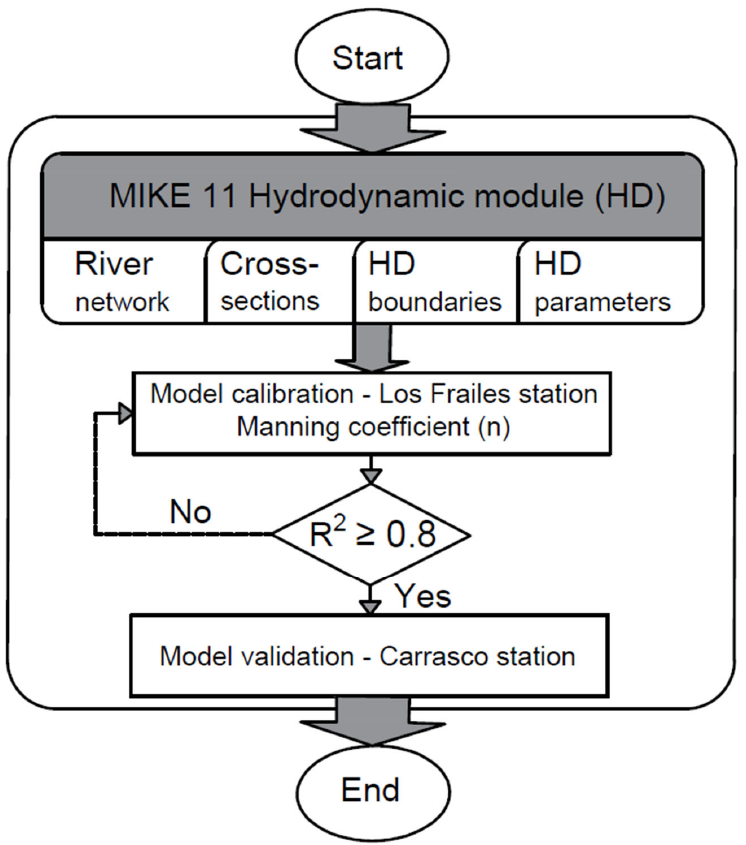
Figure 3. Algorithmic representation of the hydrodynamic modeling process in MIKE HD module.